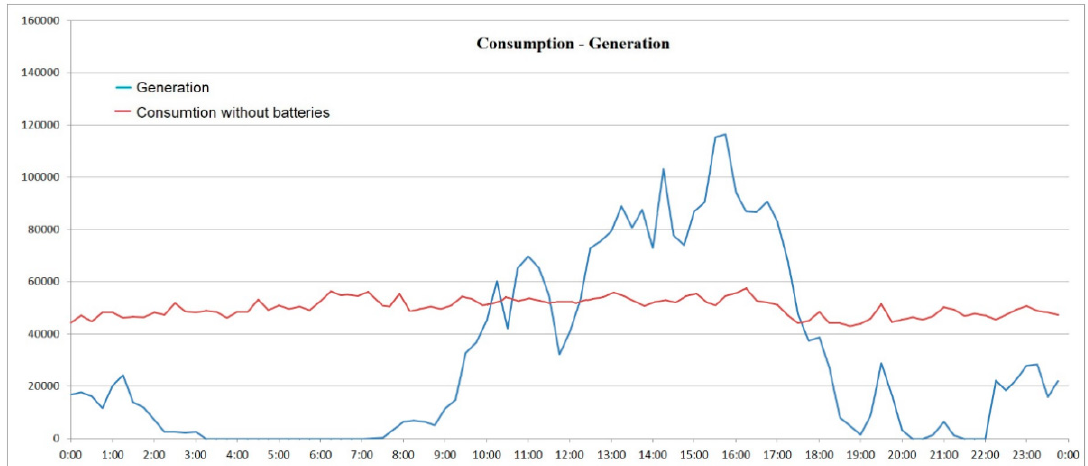
Figure 9. CEDER’s microgrid elements’ instantaneous values graphically represented. Source: prepared by authors.